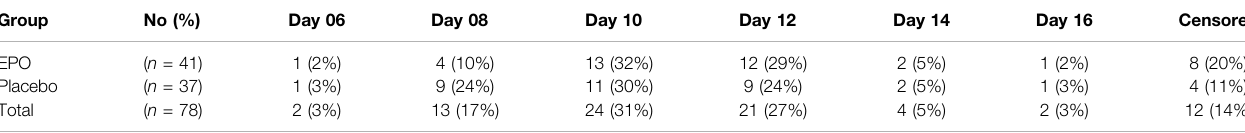
TABLE 5 | Number of patients achieving over 75% re-epithelialization.